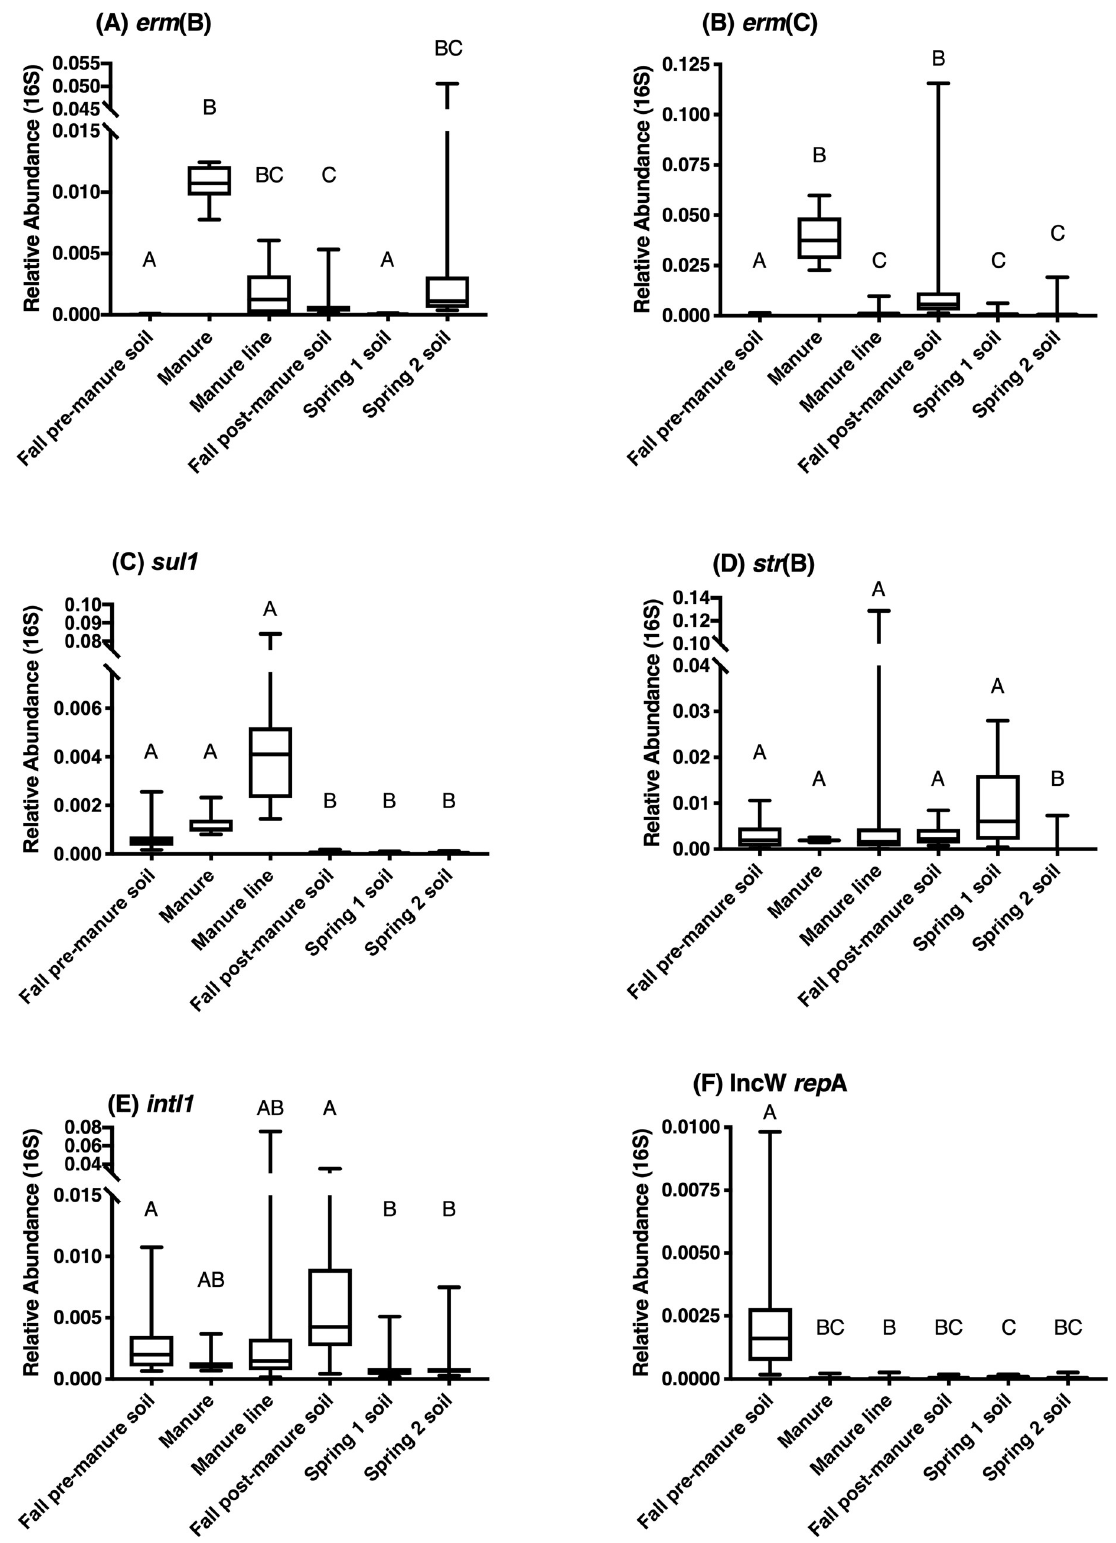
Fig 5. Relative abundance of target genes to 16S rRNA copy number. Different letters indicate significant differences (P < 0.05). n = 10 for manure. n = 20 for soil samples.